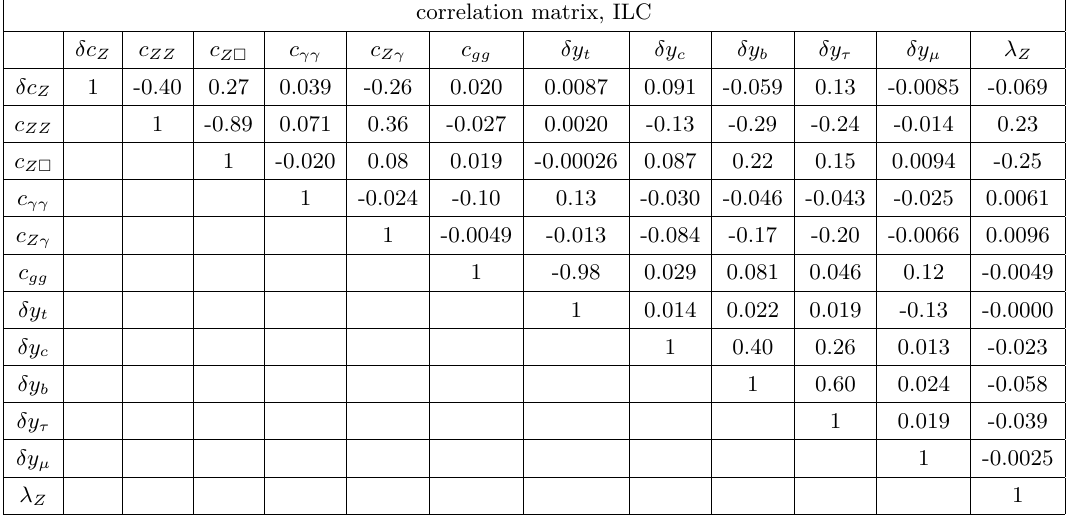
Table 14 . The corresponding correlation matrix for the ILC one sigma bounds in table 11.